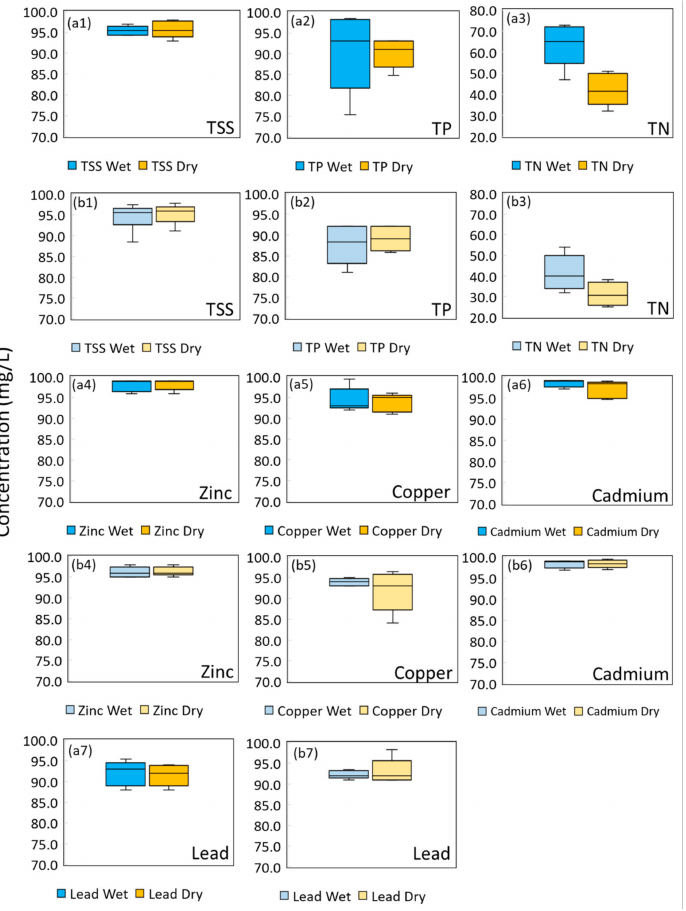
Figure 3. Phase 2 of EMC removal % for ( a1 ) TT1 TSS, ( a2 ) TT1 TP, ( a3 ) TT1 TN, ( a4 ) for TT1 Zinc, ( a5 ) TT1 Copper, ( a6 ) TT1 Cadmium, ( a7 ) TT1 Lead, ( b1 ) EMC removal % for TT2 TSS, ( b2 ) TT2 TP, ( b3 ) TT2 TN, ( b4 ) TT2 Zinc, ( b5 ) TT2 Copper, ( b6 ) TT2 Cadmium, and ( b7 ) TT2